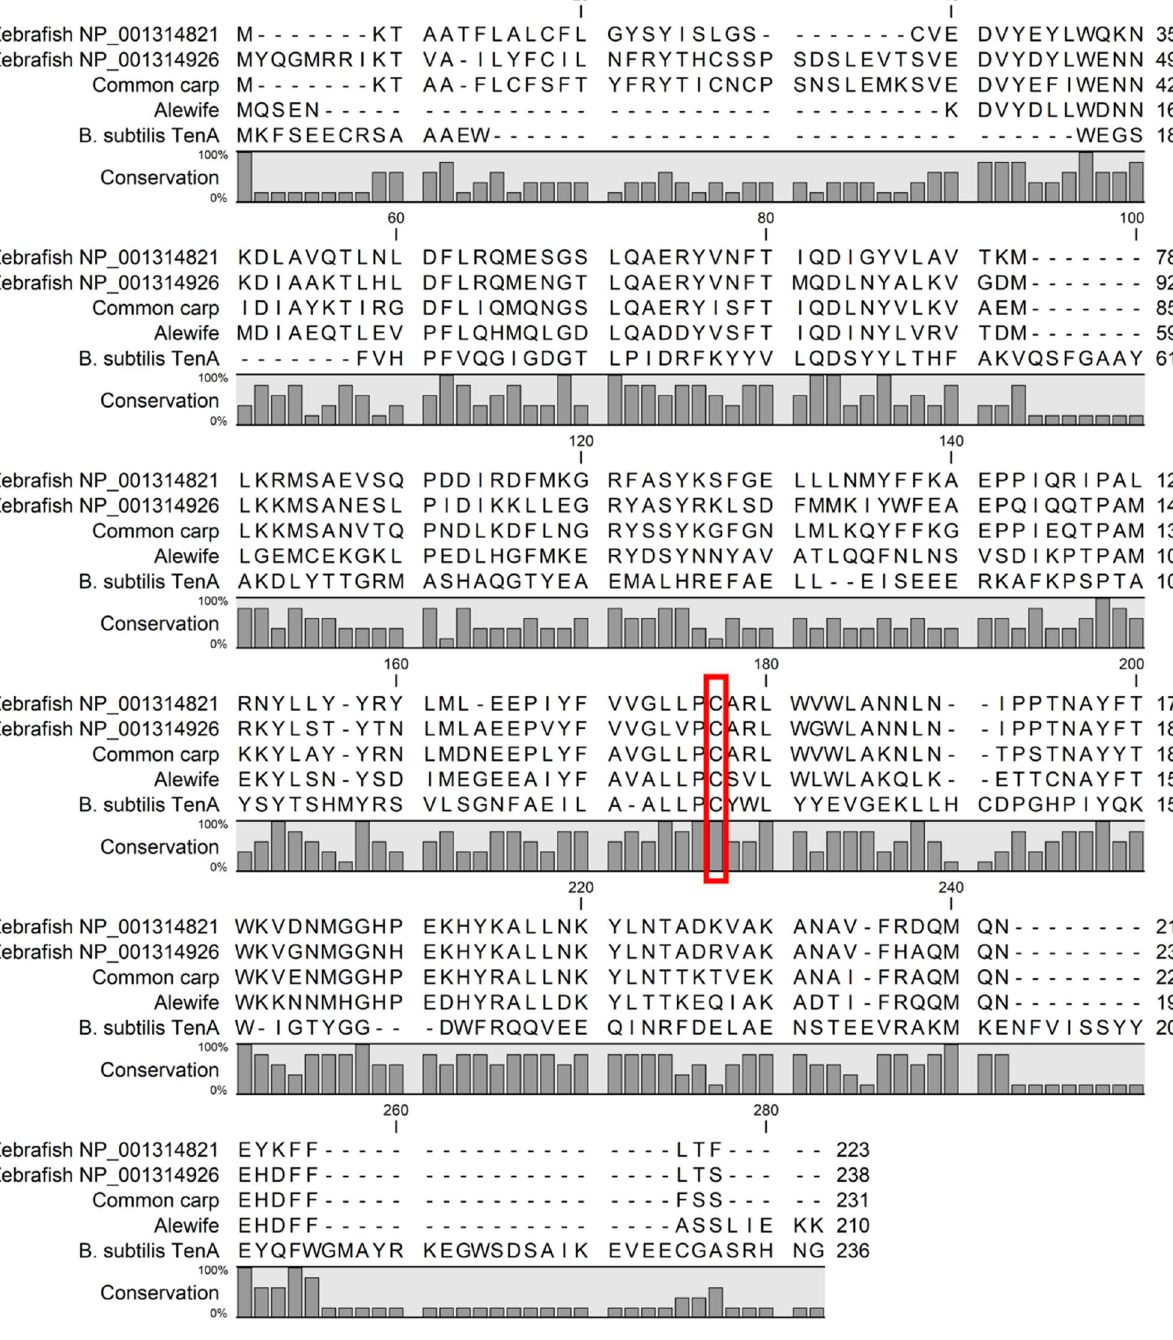
Figure 2. Alignment of known and putative thiaminases. Protein sequence alignment of candidate zebrafish ( Danio rerio ) tenA-like thiaminase I protein sequences with candidate common carp ( Cyprinus carpio ) tenA-like thiaminase I (XP_042594753), candidate alewife ( Alosa pseudoharengus ) tenA-like thiaminase I, and thiaminase II protein TenA ( Bacillus subtilis , NP_389047). The position of the TenA active site cysteine is marked with a red